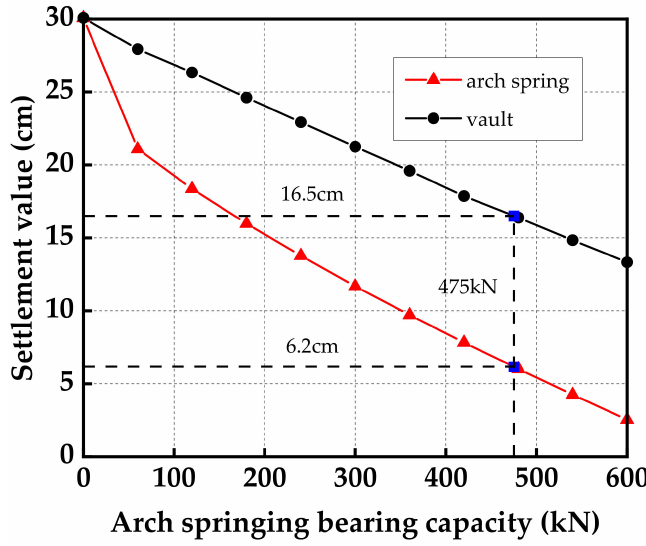
Figure 8. Vault and arch foot settlement–arch foot bearing capacity curve.